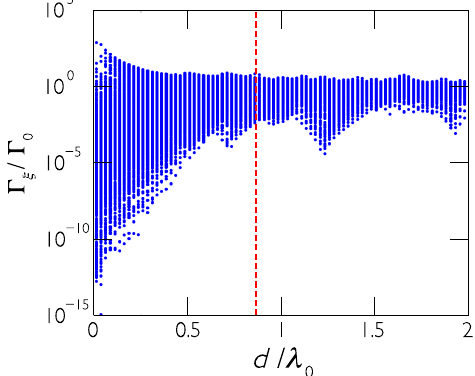
FIG. 7. Decay rate of the most subradiant mode as a function of atom number N in a circular ring of two-level atoms (black circles). Two consecutive atoms are separated a distance d as ffiffiffi shown in the sketch (here, d= λ 0 ¼ 0 . 3 ), and the atomic polari- p 3 = 2 , where zation is transverse to the plane defined by the ring. For this geometry, there is an exponential suppression of the most subradiant decay rate with N . For comparison, the decay rate of the most subradiant mode of a linear chain with lattice constant d is shown (blue circles), with only polynomial suppression with N